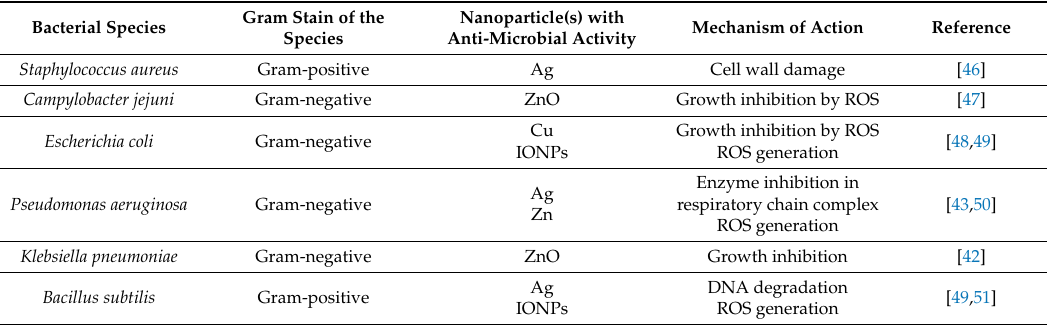
Table 1. Examples of nanoparticles exhibiting anti-bacterial properties and their mechanism of action. Gram Stain of the Nanoparticle(s) with Bacterial Species Mechanism of Action Species Anti-Microbial Activity